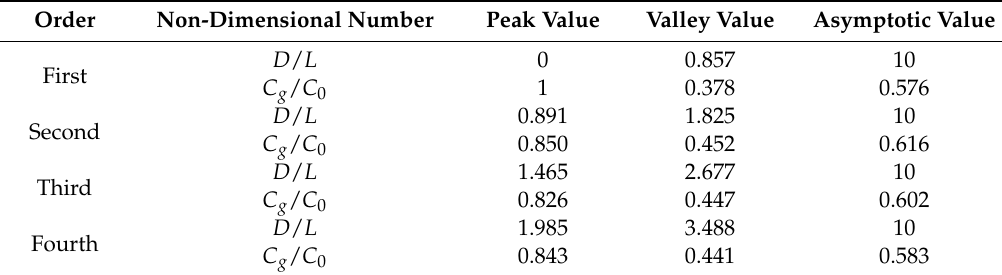
Table 2. Summary of peak, valley, and asymptotic values of the first to fourth order group velocity curves of Poisson’s ratio of